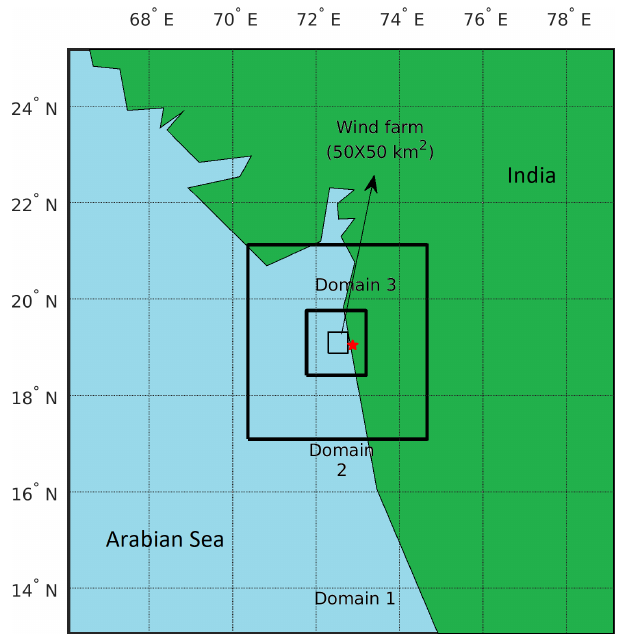
Figure 1. WRF simulation domains showing the location of the 50km × 50km wind farm within domain 3. The red star shows the METAR station location at Mumbai